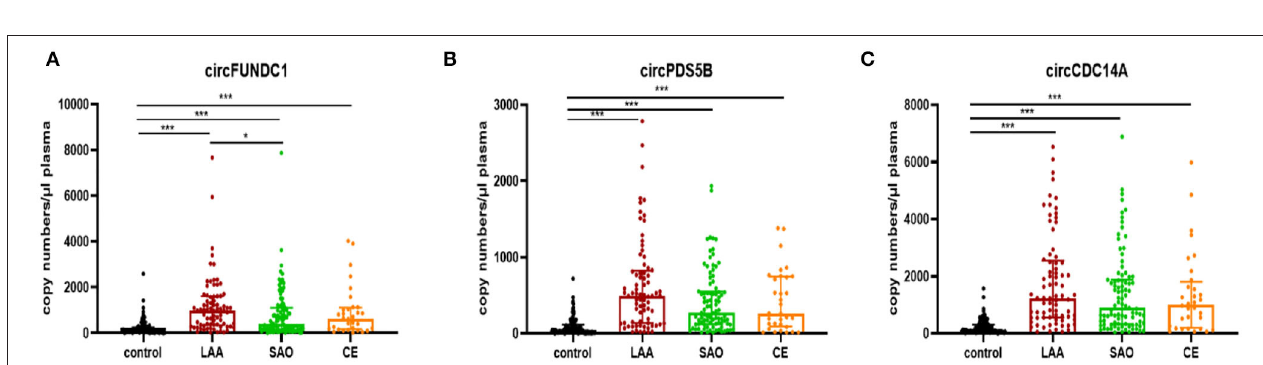
FIGURE 2 | Levels of circRNAs in acute ischemic stroke patients (AIS) with different TOAST subtypes. The plasma concentrations of circFUNDC1 (A) , circPDS5B (B) , and circCDC14A (C) from AIS patients were profiled in the TOAST categories large artery atherosclerosis (LAA), small artery occlusion (SAO), and cardioembolism (CE). TOAST, Trial of Org 10172 in Acute Stroke Treatment. Median ± interquartile range, Kruskal-Wallis H-Test. *** P < 0.001; * P < 0.05.